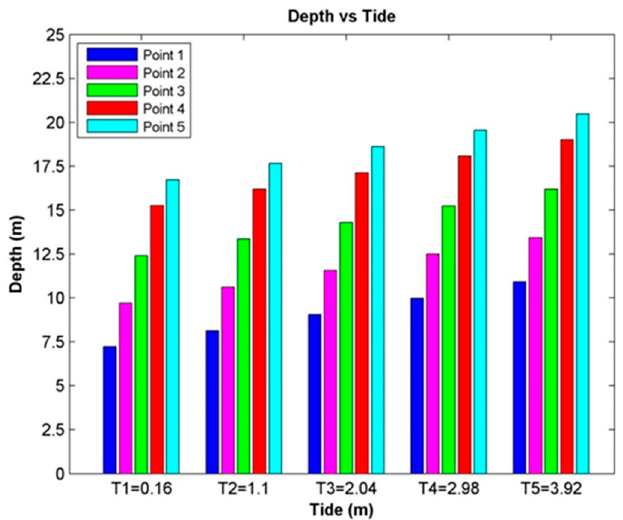
Figure 7. Variation of the water depth along the reference points (P1, P2, P3, P4, and P5) corresponding to the five tide conditions considered (T1, T2, T3, T4, and T5) from low to high tide.